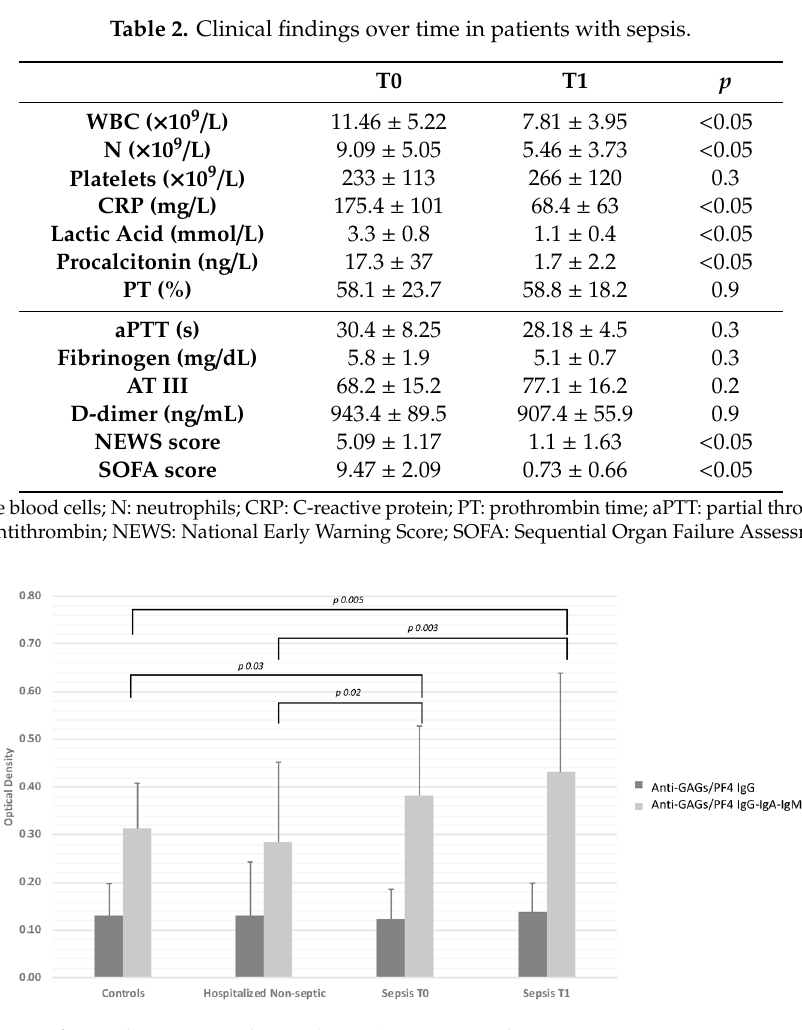
Figure 1. Titer of anti-glycosaminoglycans (GAGs) / PF4 IgG and anti-GAGs / PF4 IgG-IgA-IgM antibodies in healthy controls, patients with acute non-septic disease, and patients with sepsis, on admission (T0) and 7 ± 2 days afterwards (T1). Bars indicate mean ± standard deviation.